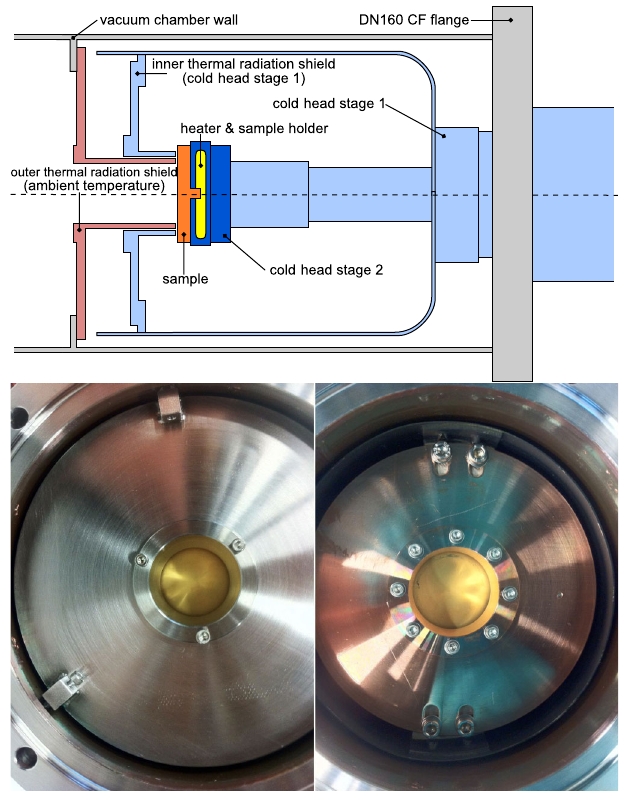
FIG. 2. Top: schematic view of the cold-head assembly used for heavy-ion-induced desorption measurements at cryogenic temperatures. Bottom left: frontal view of the cold head with installed gold-coated target and inner thermal radiation shield, thermally anchored at the first stage of the cold head. Bottom right: installed target and outer thermal radiation shield anchored at ambient temperature.